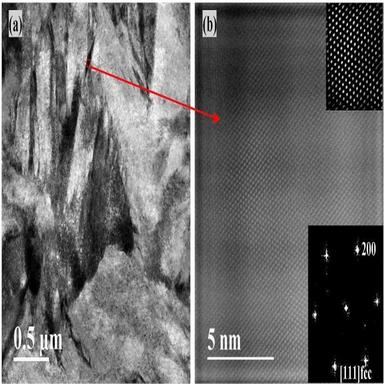
(a)TEM image, (b) corresponding HRTEM image, characterised middle region of WEL of sample A, showing lath like martensite with the presence of retained austenite at the lath boundaries.